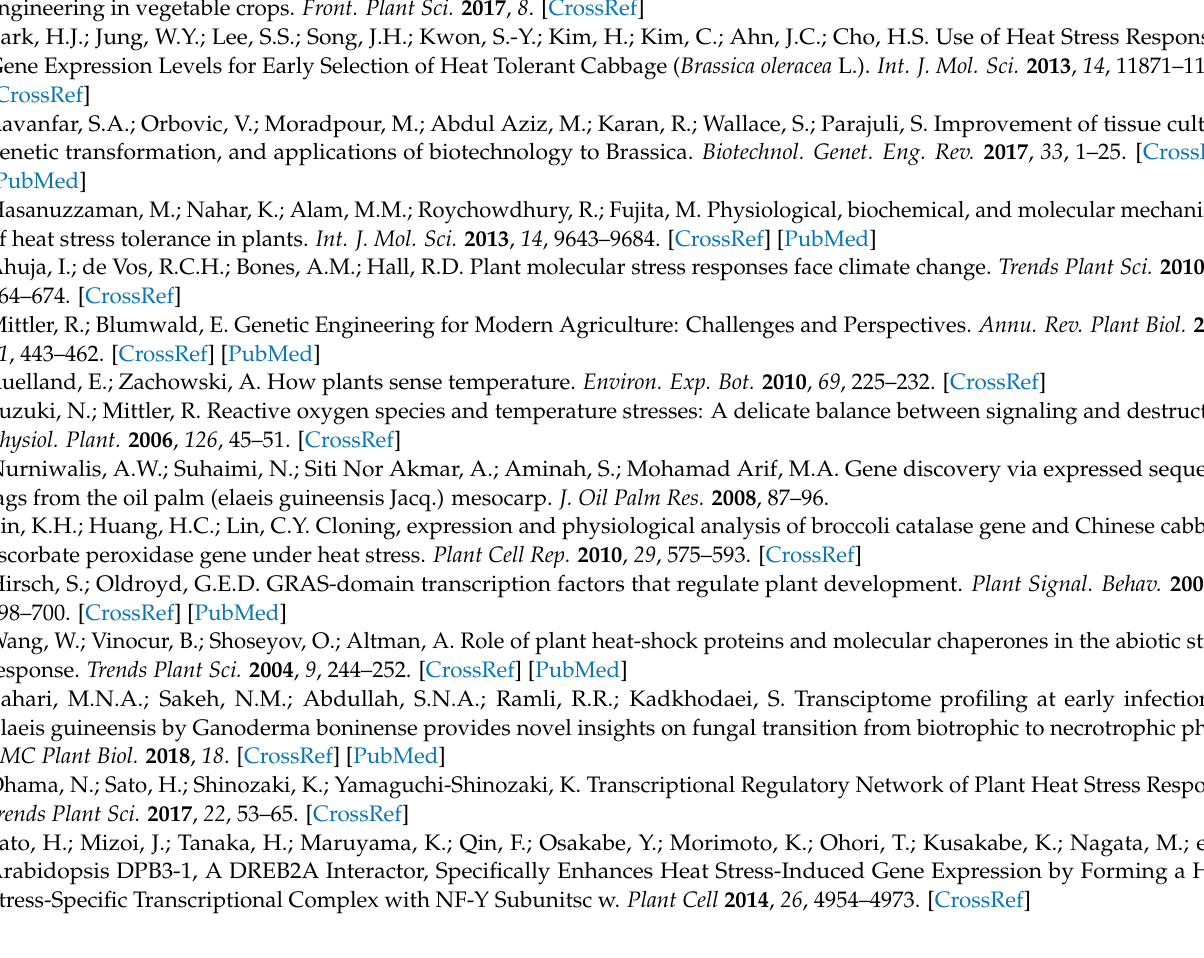
Table A2. List of the B. oleracea cultivars used in this study. Classification Source of Seeds Characteristics bright green color. Extra early maturity of 43–48 days, 1.0–1.3 kg in weight. Compact plant with semi-open, compact outer leaves suitable for density planting. Tolerant to Cabbage Yellows (B type) and Black Rot. Early maturity tropical type with excellent yield, White Cabbage P S Hybrid Cabbage uniformity, disease resistance, shippability. Petoseed Resistance: yellows, Xanthomonas campestris. High weather conditions. One round shape and Green World Cabbage average weight of 1.5 kg bright green. Resistance: yellows; high tolerance to black rot, tolerance to thrips, tipburn, heat, cold. Hybrid, round shaped head with deep purplish red color. Medium maturity of 75 days, 1.5–2.0 kg in Red Globe Red Cabbage weight. Uniform, compact, short cored head with thick and tender leaves. Good quality and taste. Slow